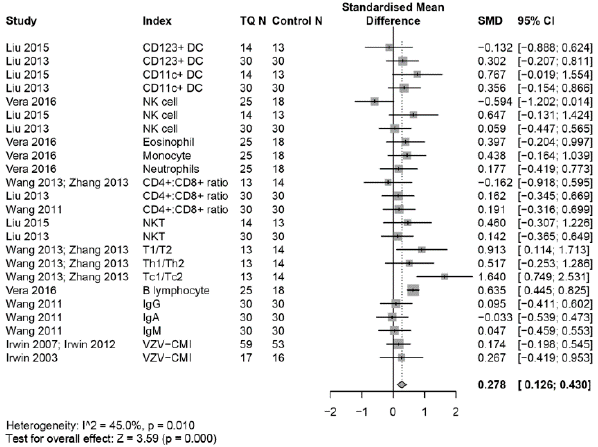
Figure 2. Forest plot for random-effects meta-analysis of the effects of TQ on the immune system.